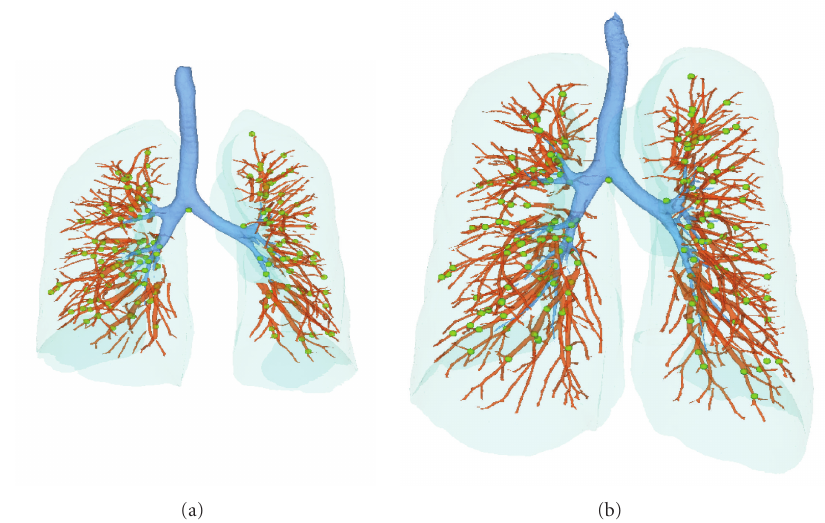
Figure 4: Distribution of landmarks (green points) selected at vessel-tree branch points on (a) FRC, and (b) TLC scans of one subject.